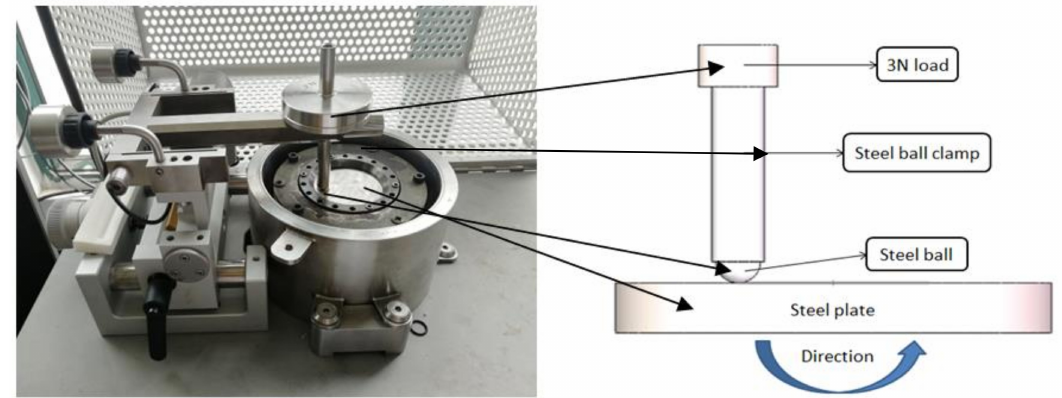
Figure 1. The high temperature tribometer and schematic view of ball-on-plate